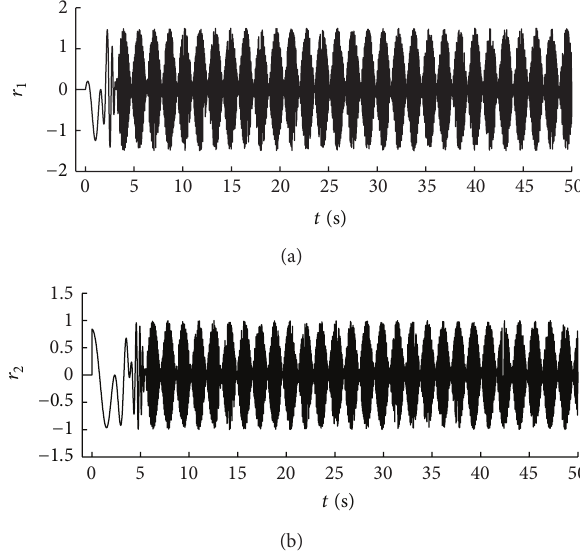
Figure 1: Time response of the reference input variable 𝑟(𝑡)